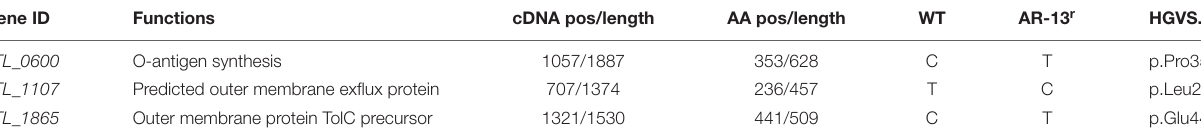
TABLE 1 | Comparative genomic analysis of an AR-13 resistant (AR-13 r ) mutant and the wild-type (WT) identified three non-synonymous mutations.